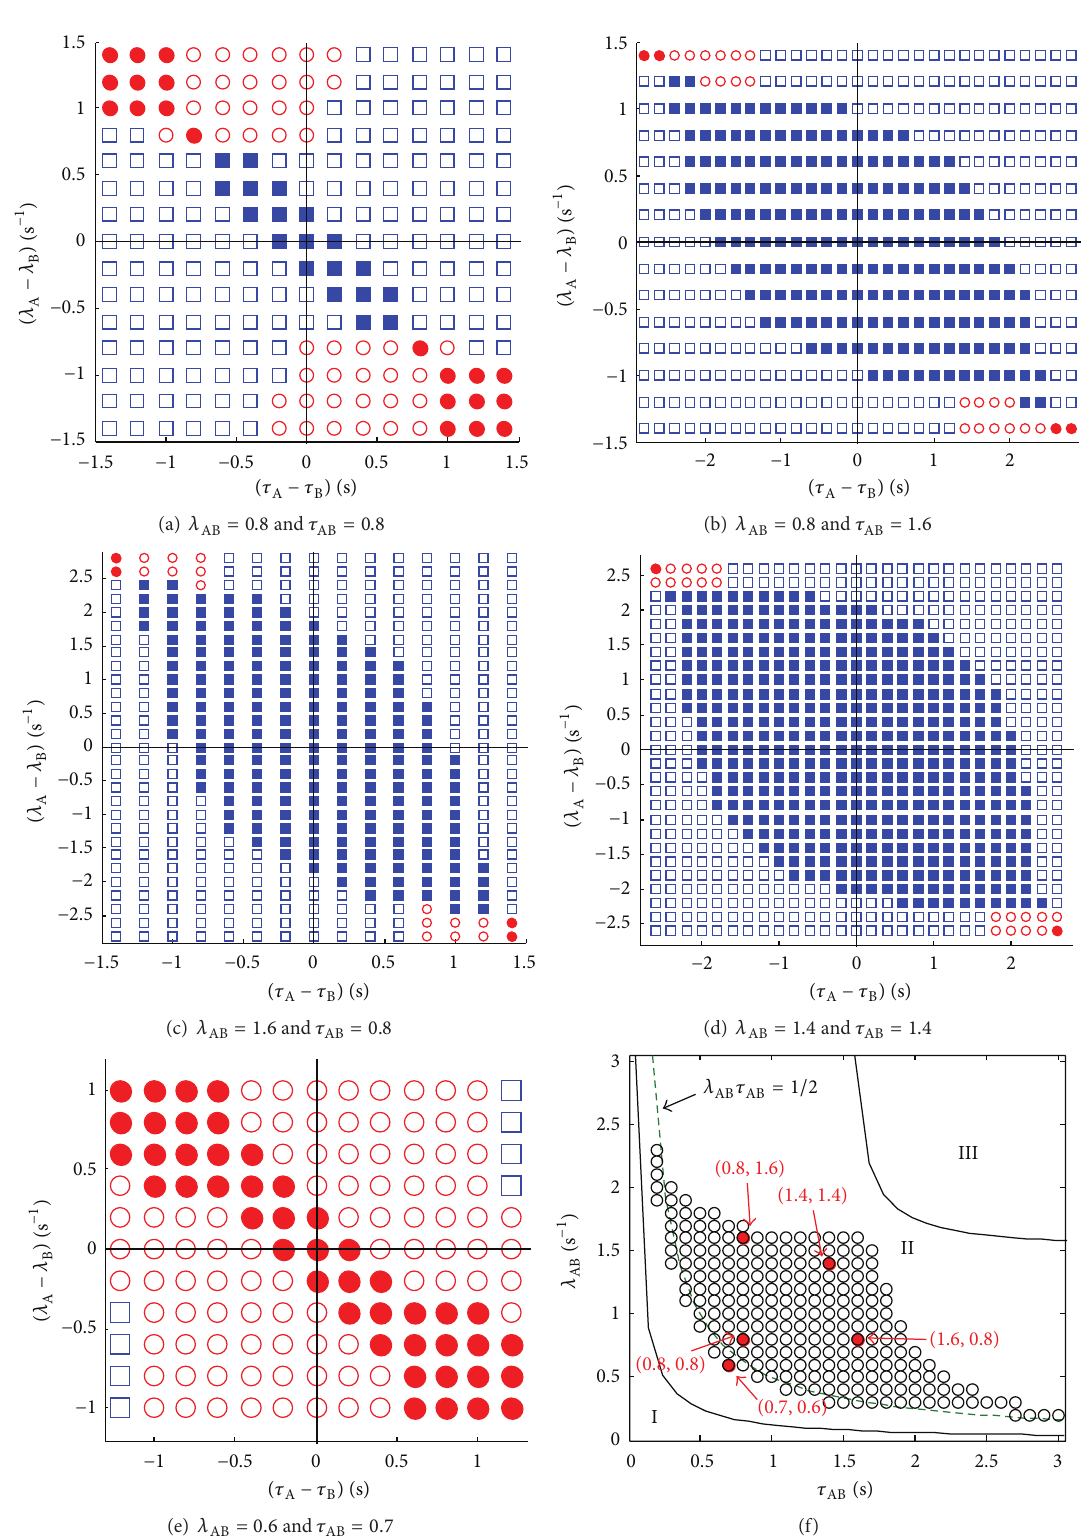
Figure 4: Stabilities under various combinations of parameters (color